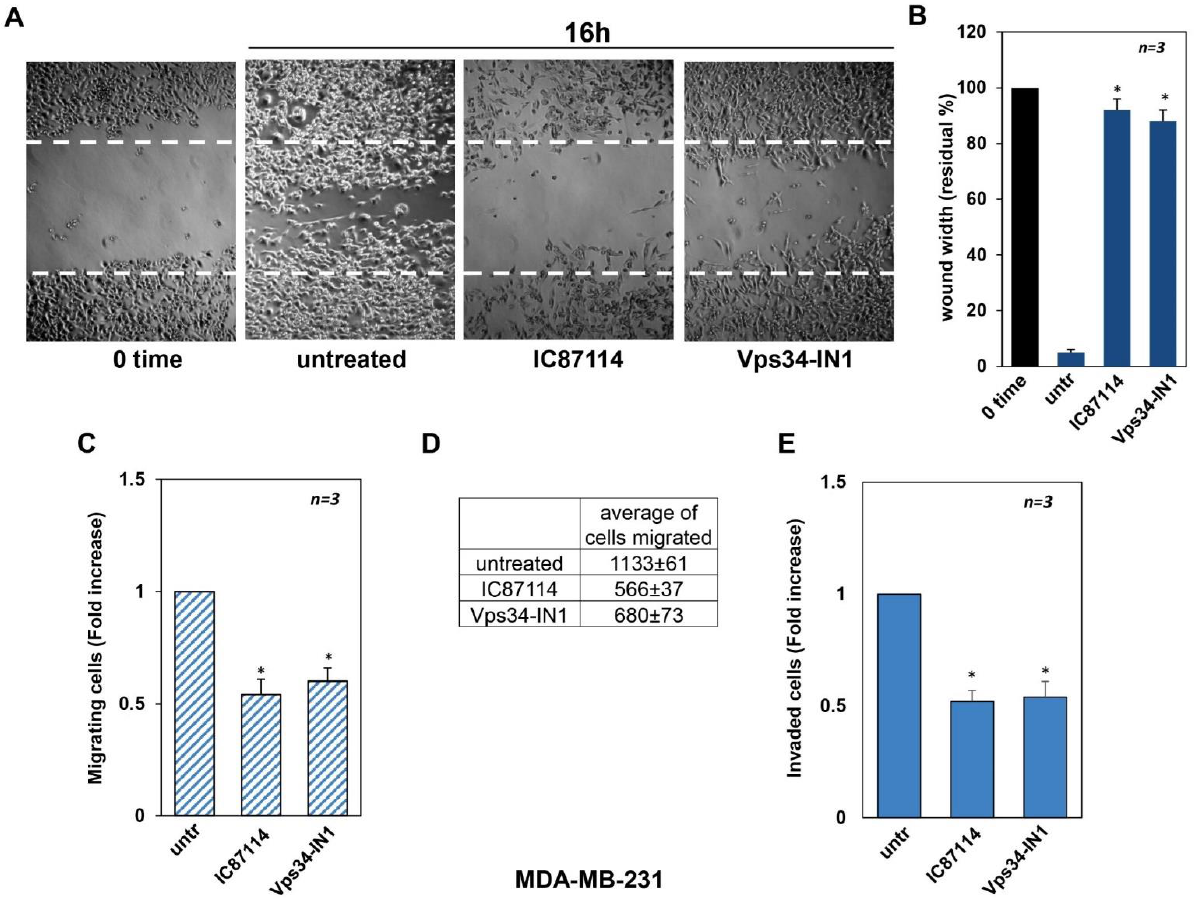
Figure 3. Effects of IC87114 and Vps34-IN1 on MDA-MB-231 cell migration and invasion. ( A ) cell monolayers were wounded, and untreated or treated for the 16 h with the PI3K p110 δ -selective inhibitor, IC87114, and Vps34-selective inhibitor, Vps34-IN1. Phase-contrast images are representative of three different experiments. ( B ) The wound area was measured using Image J Software, and data are presented as residual % in wound width over the control (0 time). ( C ) Migration assay was performed using collagen-coated Boyden’s chambers as reported in the methods section and expressed as fold decrease over the basal level (untreated cells). ( D ) The average number of MDA- MB-231 cells that migrated after 6 h in the absence or presence of the inhibitors is shown. The starting number of MDA-MB-231 cells was 30,000 cells for all experimental points, as reported and detailed in the materials and methods section. ( E ) Invasiveness was analysed by using Matrigel-coated Boyden’s chambers. ( B , C , E ) data from three different experiments were collected and analysed. Means and SEMs are shown. n represents the number of experiments. * p < 0.05 for the indicated experimental points versus the corresponding untreated